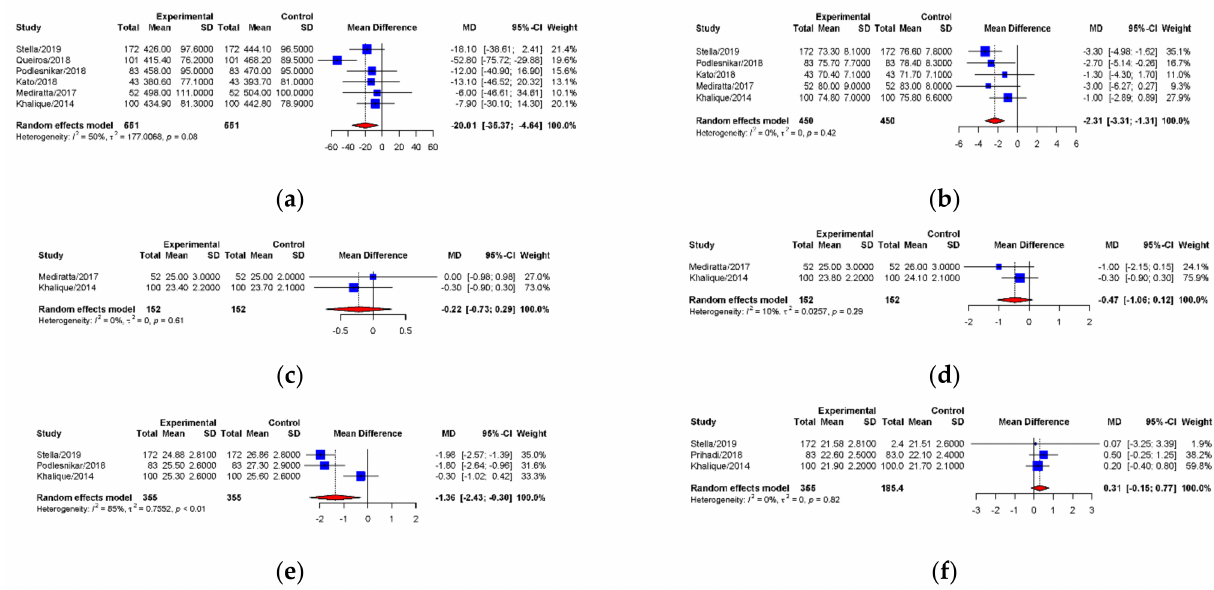
Figure 5. Forest plots of mean differences between 3D-TEE and MDCT for annular sizing parameters. p values derived from the pooled mean difference of each parameters are shown. ( a ) Aortic annular area ( p = 0.011); ( b ) Aortic annular perimeter ( p < 0.0001); ( c ) Annular area-derived diameter ( p = 0.40); ( d ) Annular perimeter-derived diameter ( p = 0.12); ( e ) Annular maximum diameter ( p = 0.012); ( f ) Annular minimum diameter ( p = 0.18). 3D-TEE = Three-dimensional transesophageal echocardiography (Experimental), MDCT = Multidetector computed tomography (Control), CI = Confidence interval, MD = Mean difference, SD = Standard deviation.